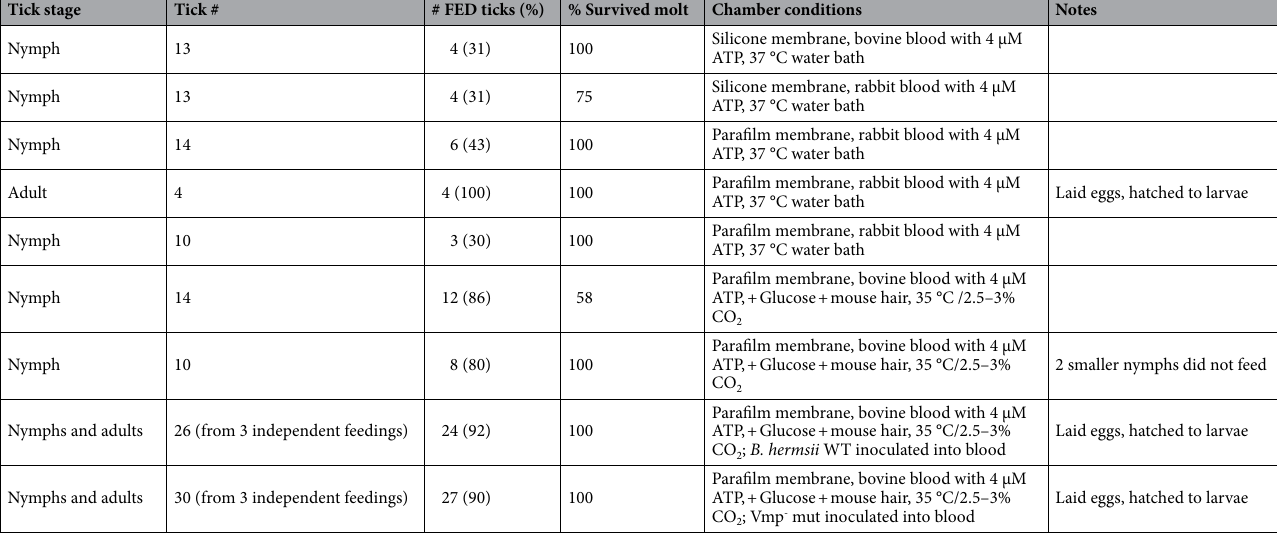
Table 1. Tick feeding efficiencies and survival results using different artificial membranes and environmental